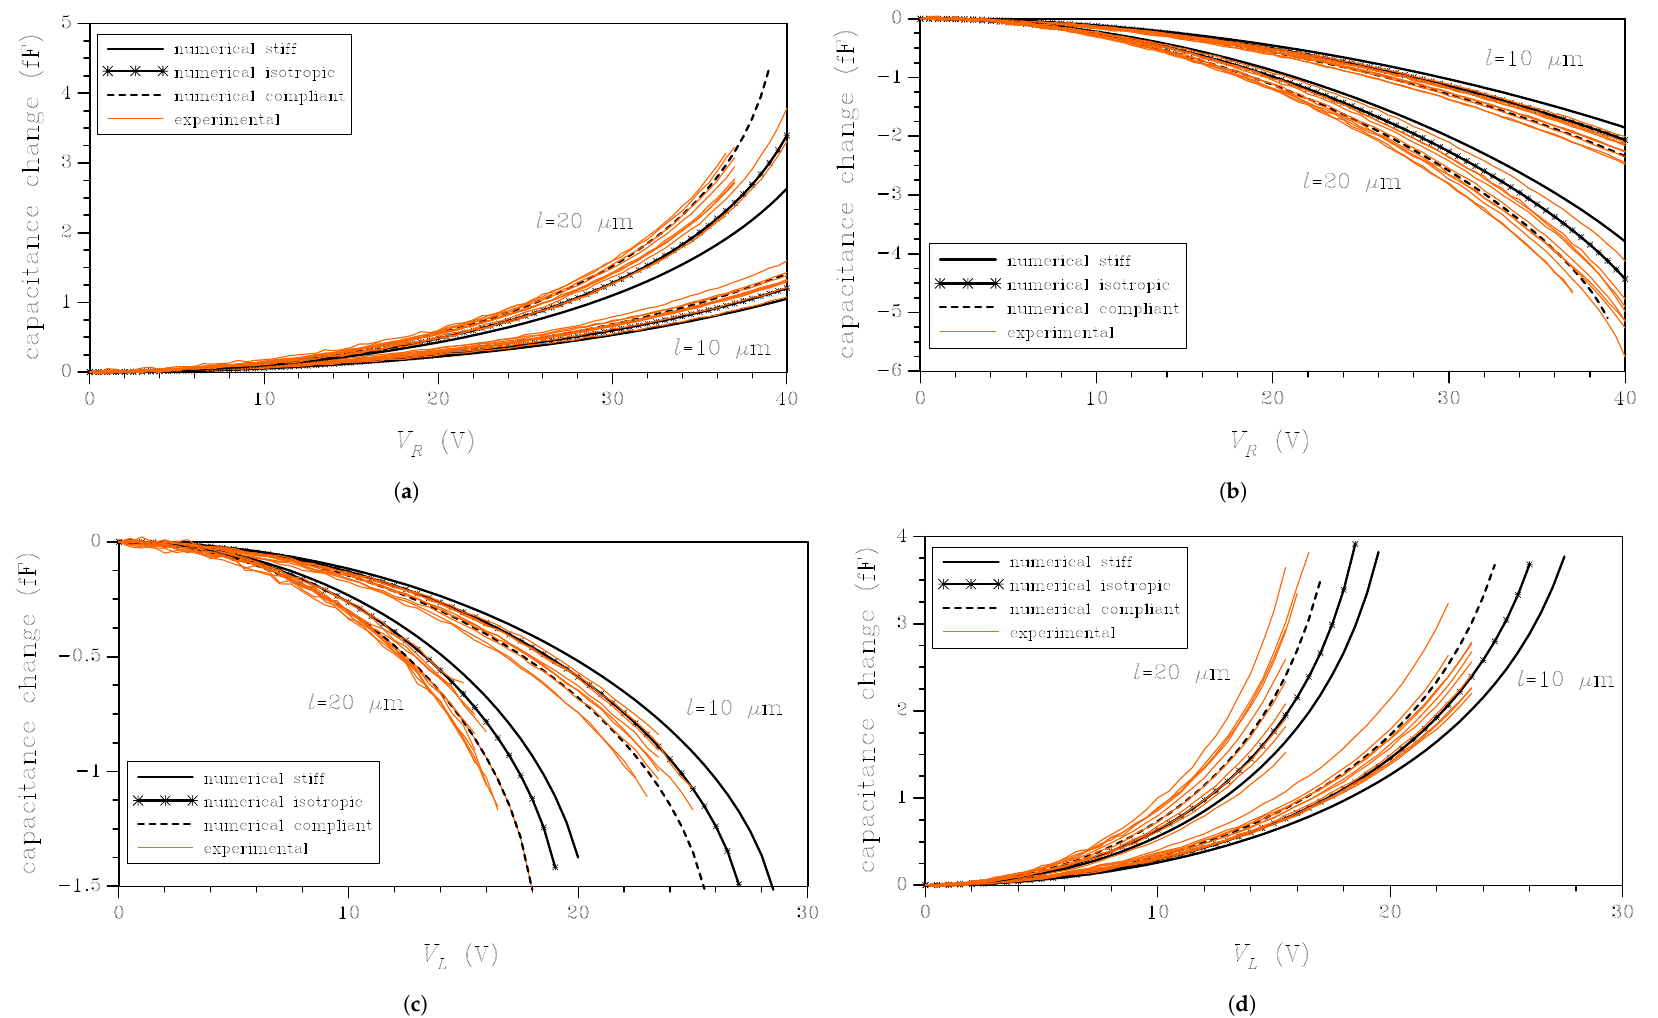
Figure 3. Experimental data and comparison with numerical results obtained using bounding and reference isotropic values for the film stiffness: ( a ) RR; ( b ) RL; ( c ) LR; and ( d ) LL test